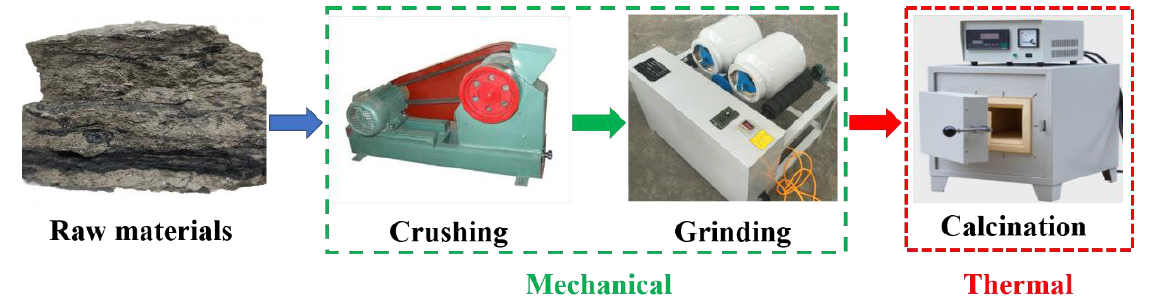
Figure 3. Schematic diagram of the composite activation procedure.